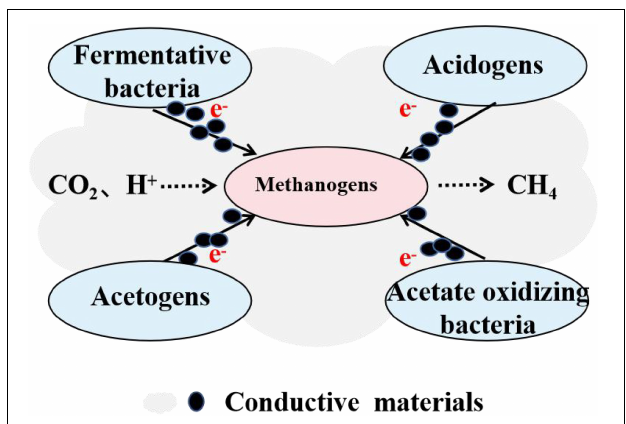
FIGURE 1 | Possible mechanisms on establishing direct interspecies electron transfer (DIET) via addition of conductive